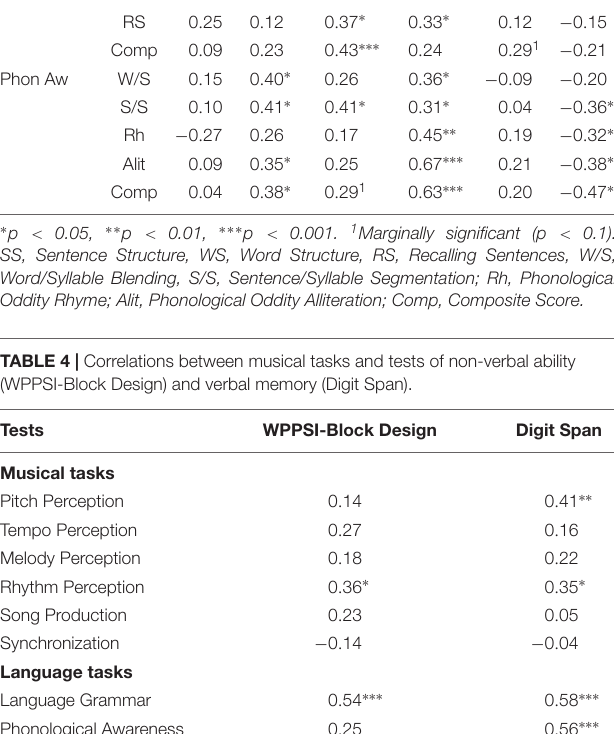
TABLE 3 | Correlations between musical tasks and subtests of phonological awareness and language structure. Language Pitch Tempo Melody Rhythm Song Synch tasks